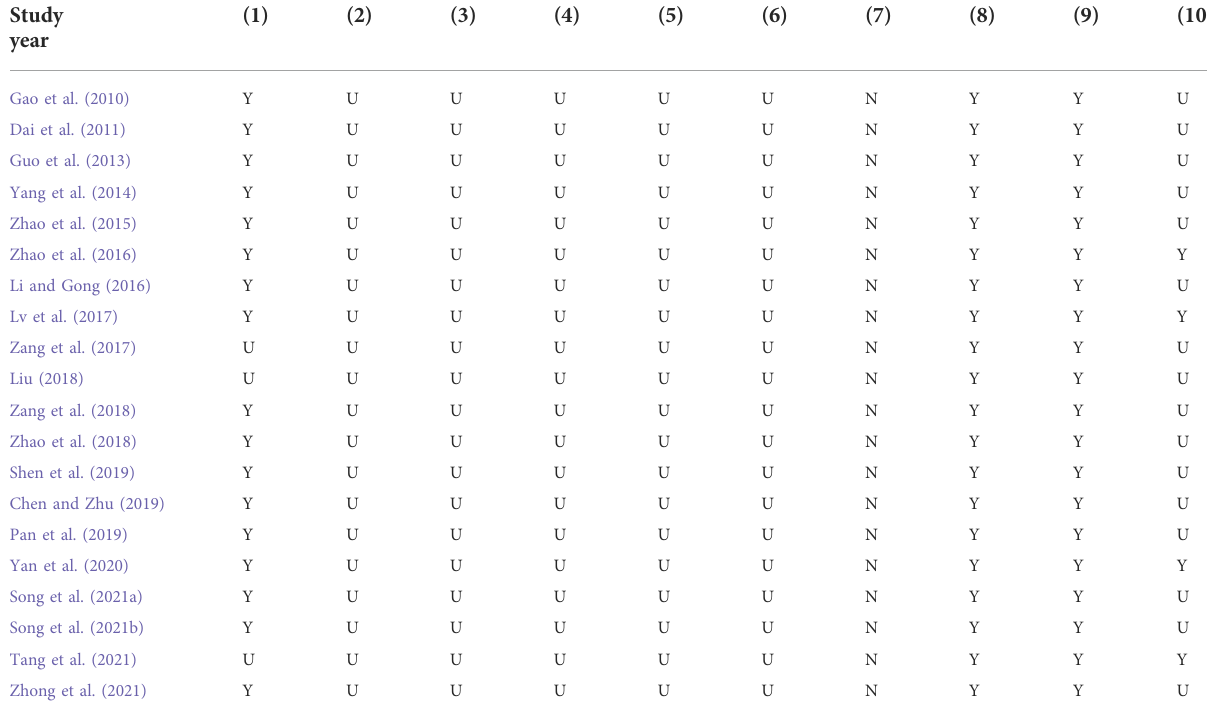
Effectiveness DAI: Thirty-three pair-wise comparisons reported the in fl uence of APS on DAI. The pooled results showed that APS could signi fi cantly decrease DAI scores compared with the control group (SMD = − 2.21, 95% CI [ − 2.78, − 1.65], p = 0.000; CMDI: Combining effect sizes from 18 pair-wise comparisons, a signi fi cant decrease in CMDI scores was observed after APS treatment, compared to that in the control CHS: Nineteen pair-wise comparisons mentioned the impact of APS on CHS. This meta-analysis showed that APS could signi fi cantly decrease CHS scores compared with the control group (SMD = − 2.91, 95% CI [ − 3.77, − 2.04], Figure 4). MPO: Twenty-four pair-wise comparisons mentioned the in fl uence of APS on MPO. The pooled effect sizes indicated that APS could signi fi cantly decrease MPO activity compared with the control group (SMD = − 3.70, 95% CI [ − 4.73, − 2.66], p = Figure